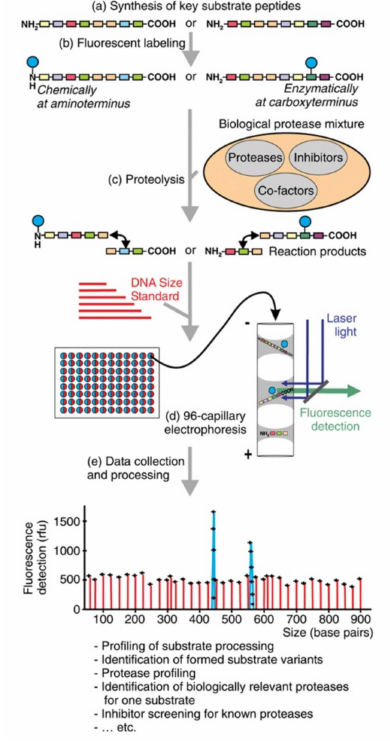
Figure5. Microfluidicdevices used for parallel electrophoretic enzyme assays. ( a ) Design of microfluidic network containing 16 parallel separation channels, ( b ) design of a 36-channel network, ( c ) photograph of a finished 36-channel chip, ( d ) bright-field image of the detection area on the 36-channel chip, ( e ) repetitive units of the microfluidic network. The Electrokinetic injection procedure is described in experimental section. Reproduced with the permission of